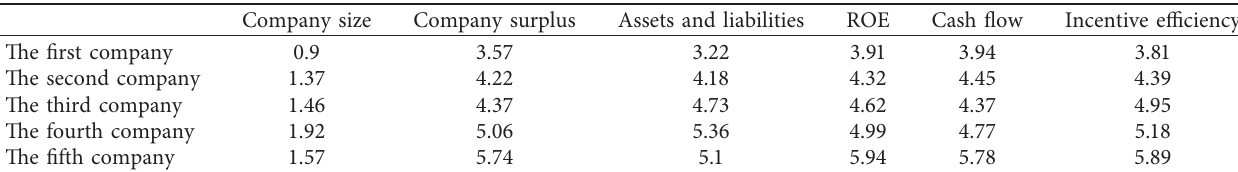
Table 5: Improved data.